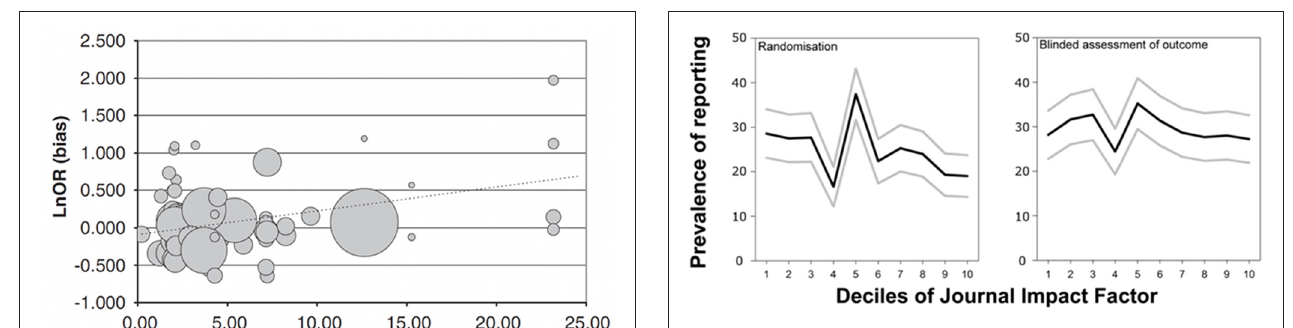
FIGURE 4 | High ranking journals do not have a higher tendency to report more randomization nor blinding in animal experiments. Prevalence of reporting of randomization and blinded assessment of outcome in 2671 publications describing the efficacy of interventions in animal models of eight different diseases identified in the context of systematic reviews. Figure modified from Macleod et al. (2015).